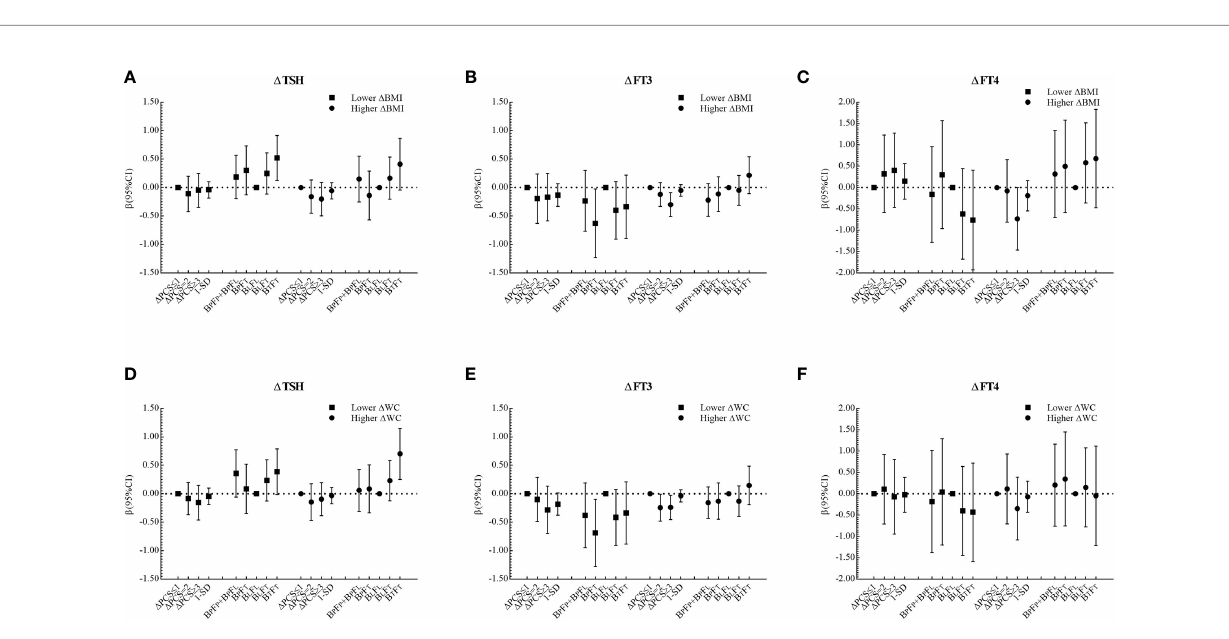
FIGURE 3 | b and 95% con fi dence interval (95% CI) for D THs according to D PCS and puberty pattern by multiple liner regression analyses (Model 2) after being strati fi ed by D BMI level or D WC